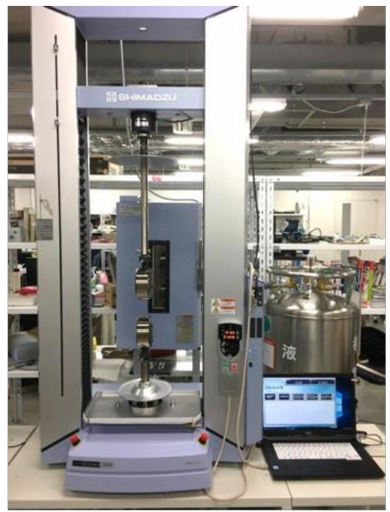
Figure 4. Universal mechanical testing machine (AG-X plus, SHIMADZU Co., Ltd., Kyoto, Japan) for conducting tensile